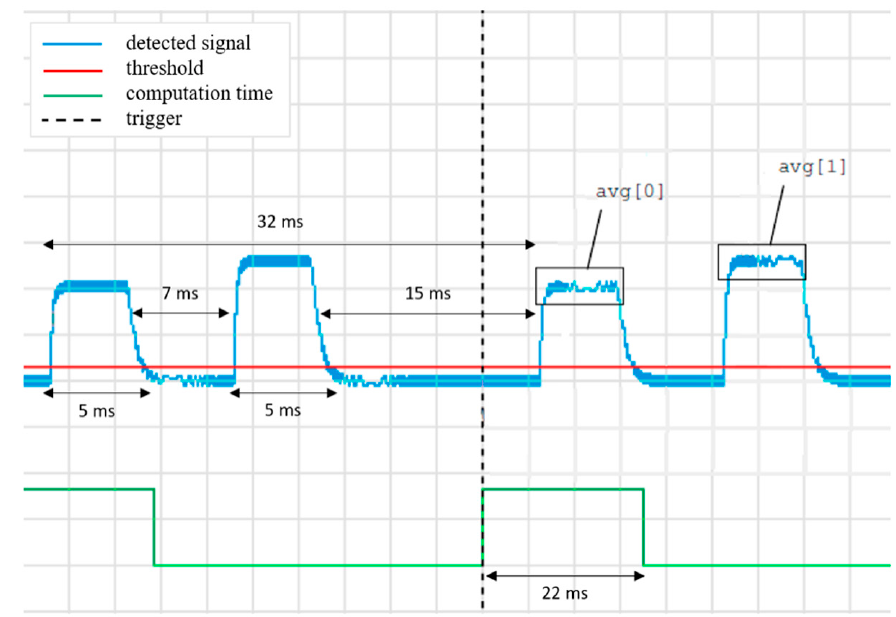
Figure 4. Sample of the analog signal entering the analog-to-digital (AD) converter of the microcontroller (MCU). The two bursts generated by the left and right boundary wires are detected as a pair of consecutive pulses with different amplitudes, according to the runner’s position. The busy flag of the MCU. After 10 ms of signal below the gate threshold (red line), the MCU is triggered to start the evaluation of the sampled buffer. After the computation time, the amplitude difference between the two previously measured pulses is eventually output on the vibration motors. The peak amplitude average was calculated for both the left and right boundaries, and